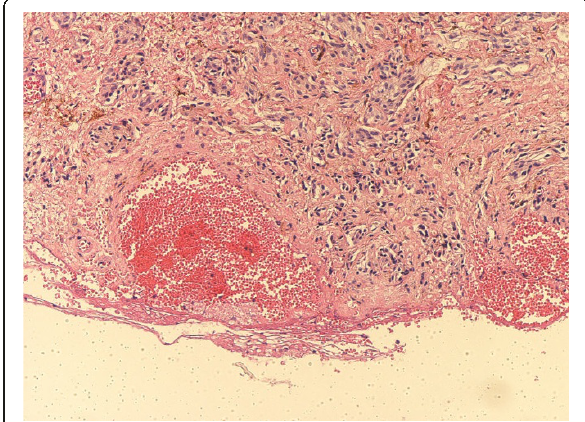
Figure 4 Photomicrograph of the cavity . There are a blood-filled, nonendothelial lined pseudovascular spaces surrounded by the dendritic melanocytes (original magnification, × 40, hematoxylin and eosin stain).